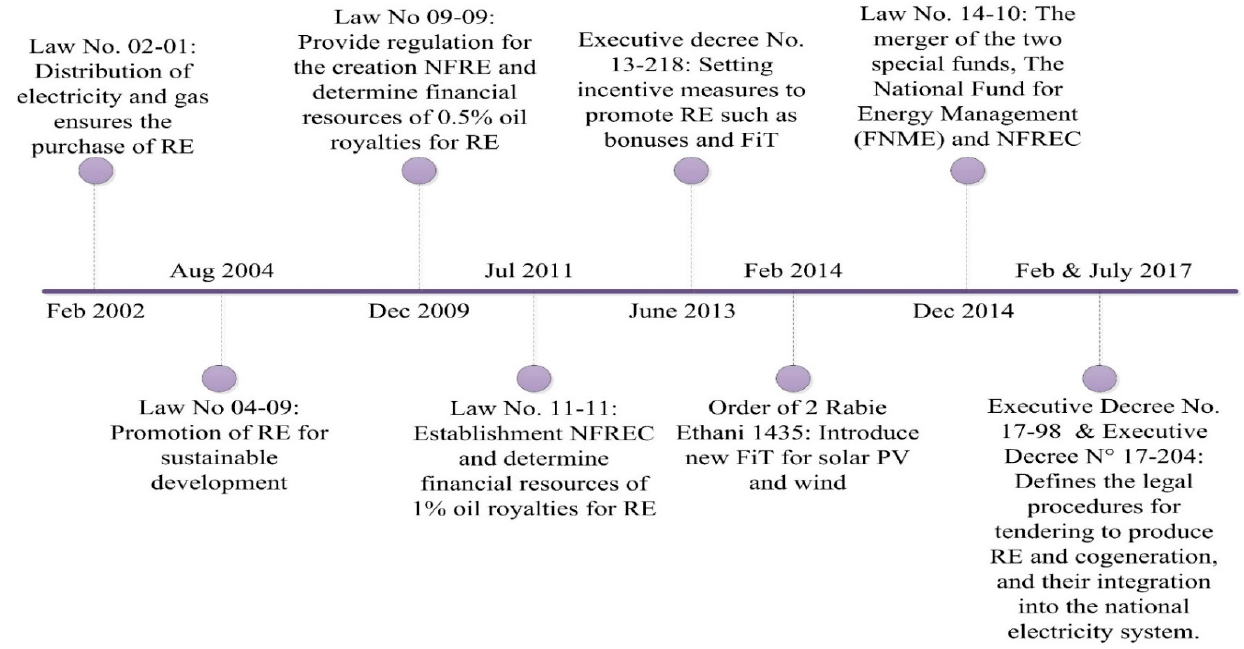
Figure 15. Major laws and regulations related to RE in Algeria.